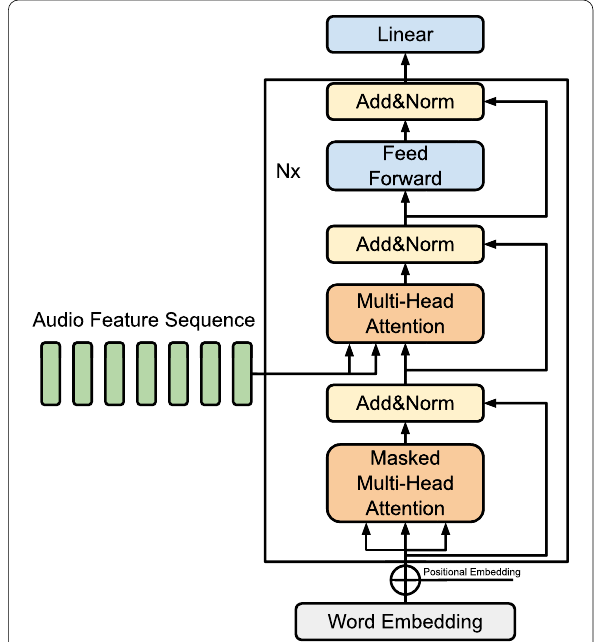
Fig. 6 Diagram of a Transformer-based language model. When generating a word at each time step, the masked multi-head attention module attends to the previously generated words to exploit contextual information. The output of the masked self-attention module is then fused with the audio feature sequence from the encoder in the cross-attention